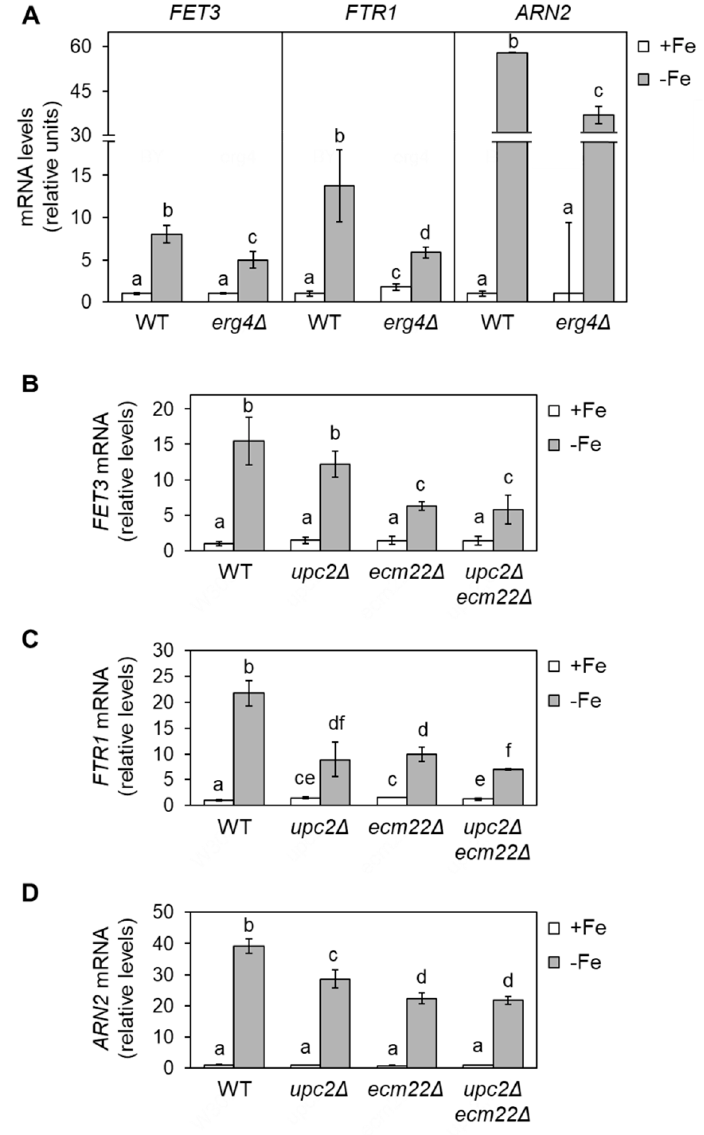
Figure 2. Defects in ergosterol biosynthesis limit the up-regulation of iron regulon genes during iron deficiency. ( A ) Wild-type (WT, BY4741) and erg4 Δ cells were cultivated in SC at 30 °C in SC medium without (+Fe) or with 100 µM BPS ( − Fe) for 6 h. ( B – D ) Wild-type (WT, W303), upc2 Δ , ecm22 Δ , and upc2 Δ ecm22 Δ cells were grown for 15 h to exponential phase in SC medium (+Fe) and then 100 µM BPS was added, and cells were cultivated for 9 h ( − Fe). Total RNA was extracted, and mRNA levels of FET3 , FTR1, and ARN2 were determined by RT-qPCR as indicated in Material and Methods. Data were normalized to PGK1 ( A ) or ACT1 ( B – D ) mRNA levels. Data display the average and standard deviation (SD) of three biologically independent assays relative to wild-type cells in +Fe conditions. Different letters above bars indicate statistically significant differences ( p -value < 0.05).